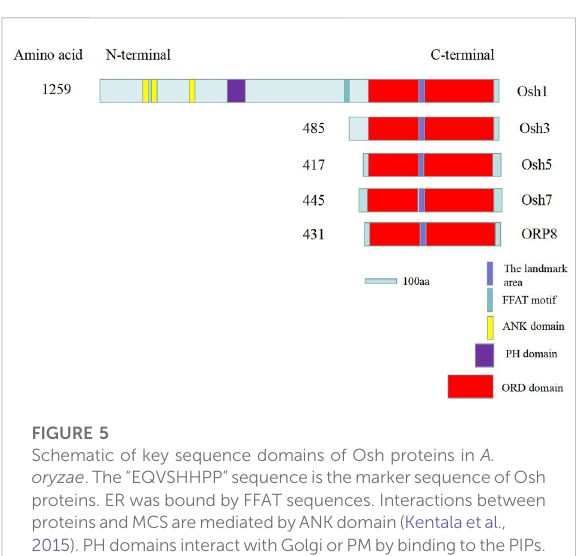
their PH domain (Kentala et al., 2015; Ma et al., 2019). OSBP and